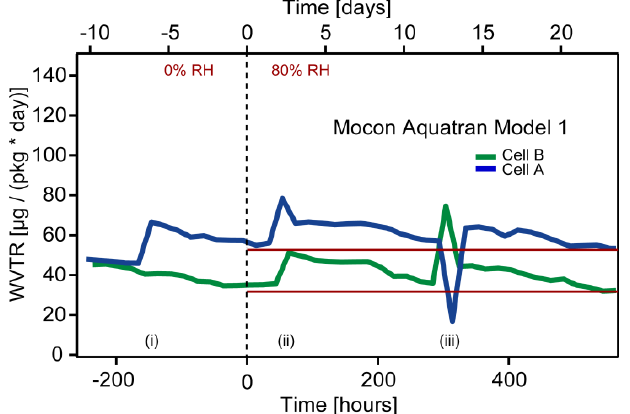
Figure 3. WVTR results from Mocon Aquatran Model 1 equipment. Cell A is the encapsulation from a fresh battery cell. Cell B is from a vibration tested